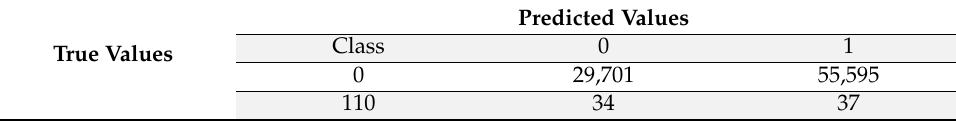
Table 15. Confusion matrix of DRL on imbalanced